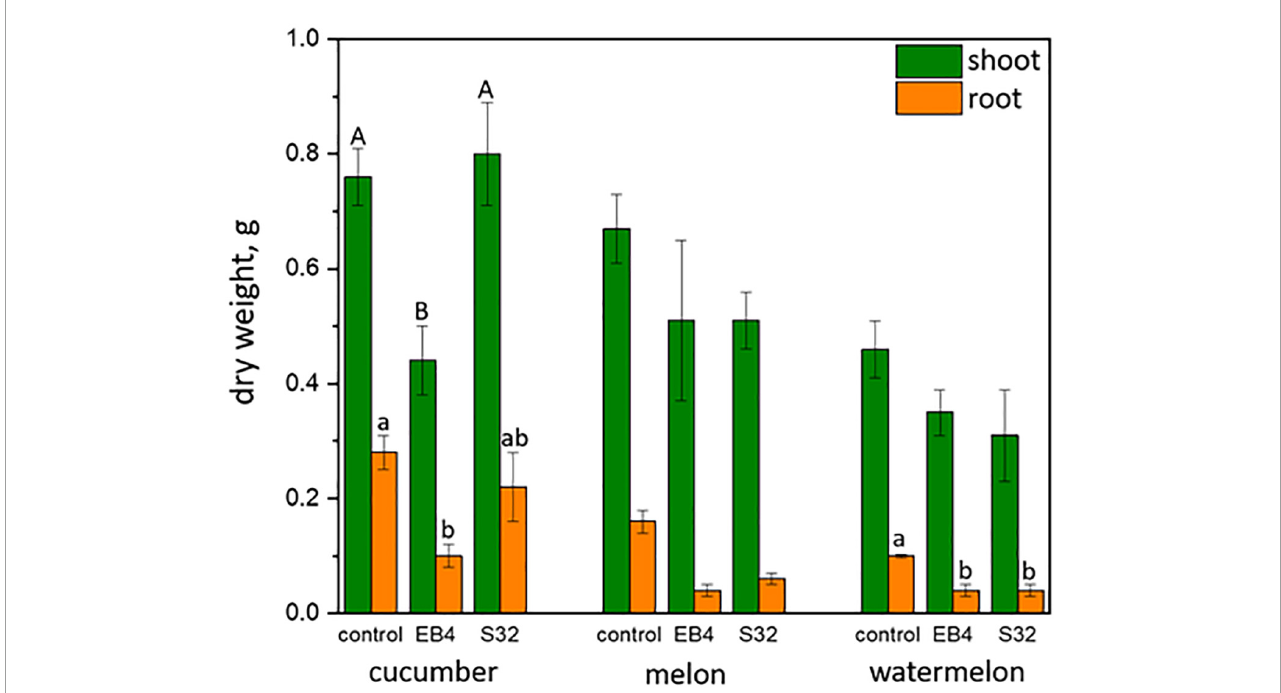
FIGURE6 Shoot and root dry weight (mean ± standard error) of cucurbitaceous plants inoculated with Diaporthe atlantica strain EB4 and Diaporthe iberica strain S32. For each plant species and organ, letters on columns indicate significantly different means.